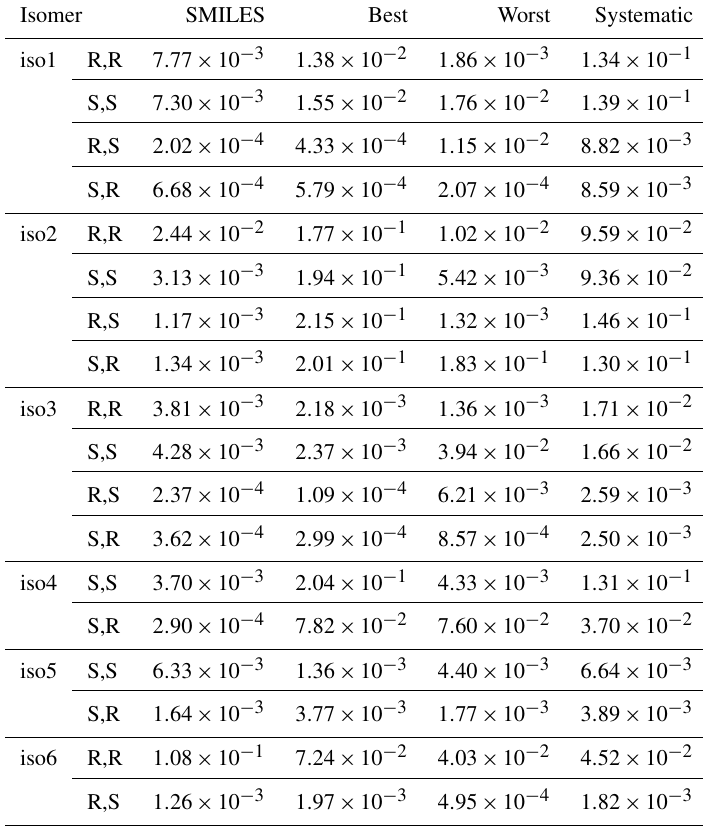
Table 1. Saturation vapor pressures, in Pa, at 298.15K, of different structural and stereoisomers of the dihydroxy dihydroperoxide C 5 H 12 O 6 , calculated using COSMOtherm version 18 and the BP_TZVPD_FINE_18 parameterization (based on BP/def2-TZVPD//BP/def-TZVP quan- tum chemical data). The experimental value (for an unknown mixture of isomers) is 9 . 87 × 10 − 5